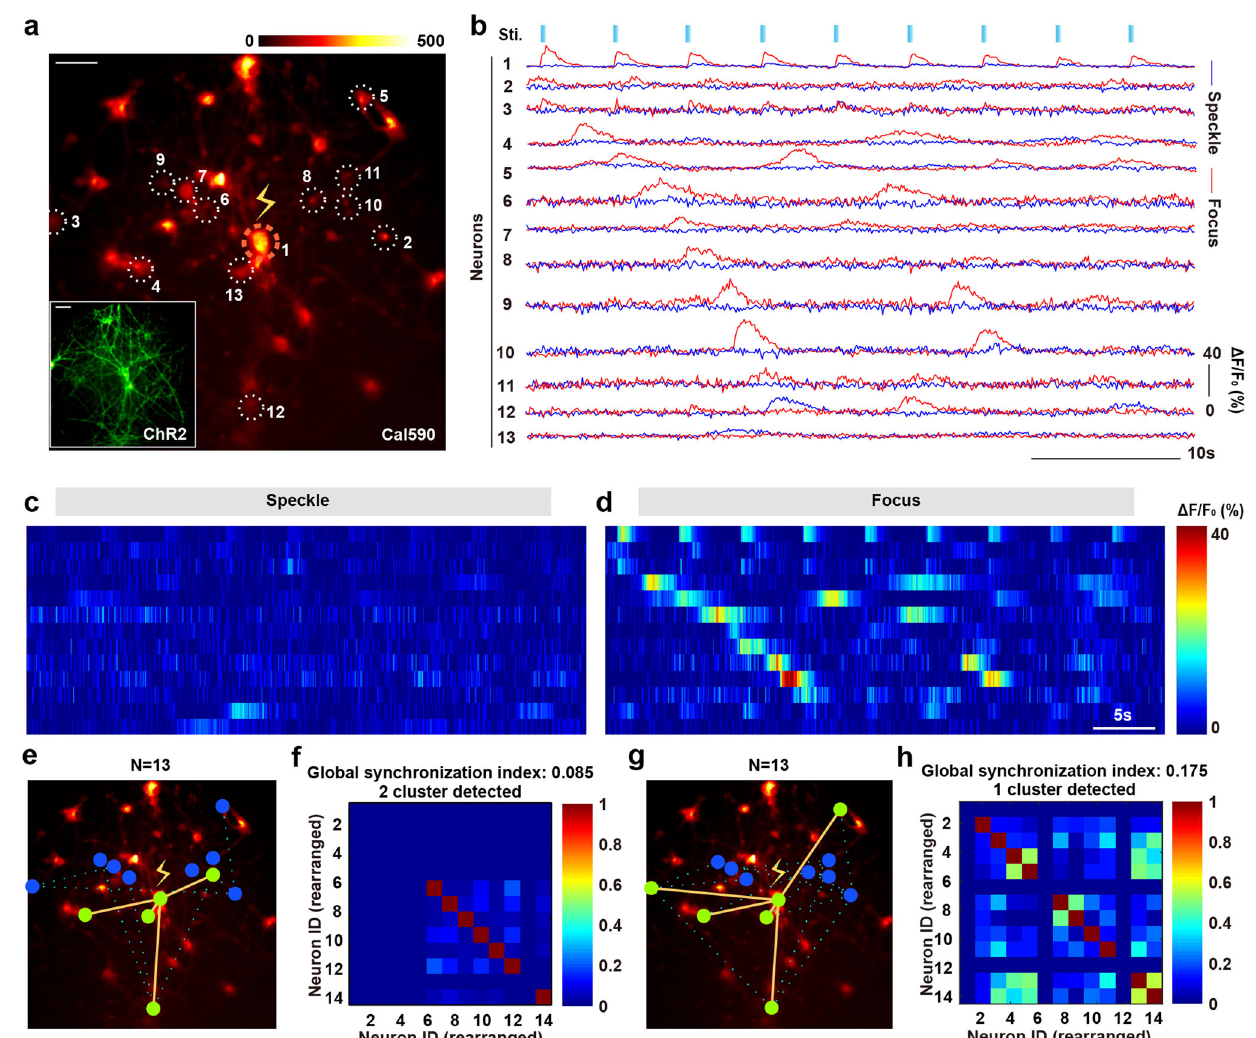
Fig. 5 Neural signaling research with the use of fCOAT generated focus stimulation. a Targeted activation of calcium signaling in representative neurons. Red: Cal590 fl uorescence signal. Green: the expression of the opsin ChR2 used. Neuron 1 is the target stimulation neuron, and the rest are neurons that follow the response. b Individual traces of Cal590 fl uorescence in 13 different ChR2 neurons under 488 nm illumination, using extended focusing and speckle light fi elds. The red line: focus, the blue line: speckle. c Individual traces of Cal590 fl uorescence in different ChR2 neurons under 488 nm illumination using speckle light fi elds. d Individual traces of Cal590 fl uorescence in different ChR2 neurons under 488 nm illumination using focus light fi elds. e Speckle light activation of neuron 1 triggers estimation of functional connectivity of different neurons. Functional connectivity of pairs of neurons (orange line, green dots) centered on neuron 1 is determined by testing the statistical dependence of neuronal calcium activity. f Quanti fi cation of Synchronization Index and cluster number under speckle light illumination. g Focus light activation of neuron 1 triggers estimation of functional connectivity of different neurons. h Quanti fi cation of Synchronization Index and cluster number under focus light